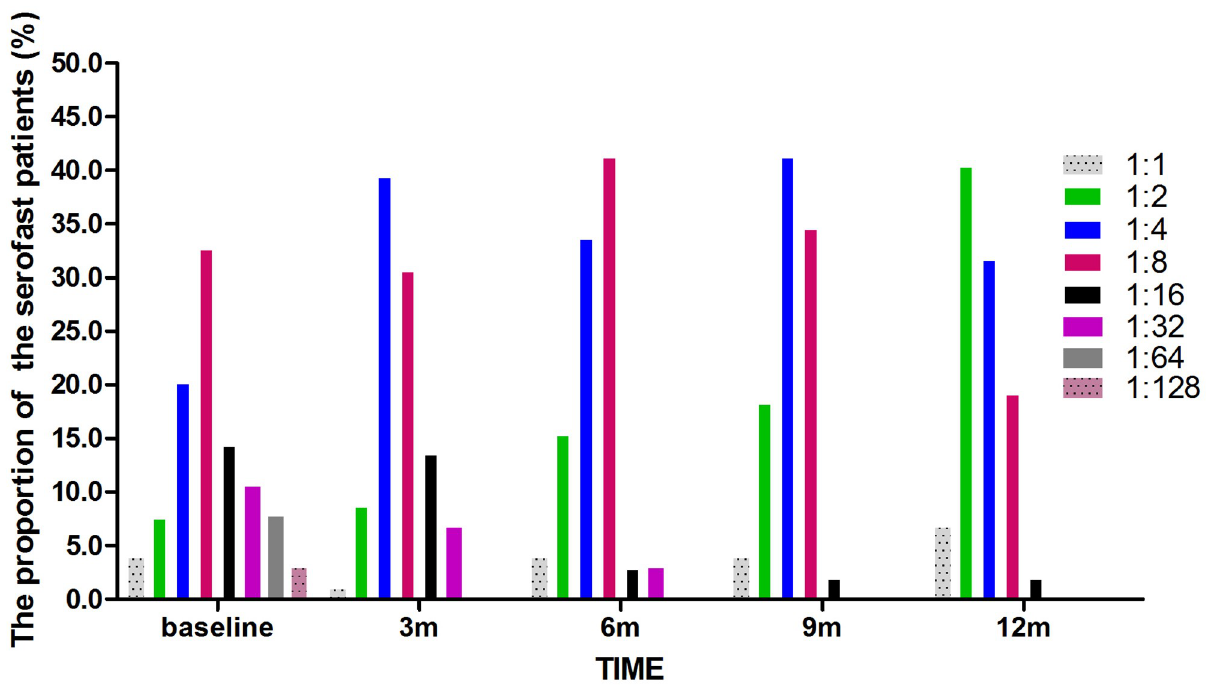
Fig 4. The proportion of serofast patients by different time points RPR titre. At different time points, the RPR titres in serofast patient changed.The proportionof patients with RPR titres of (cid:20) 1:8 increasedfrom 64.4% at baselineto 98.0% at 12 months.